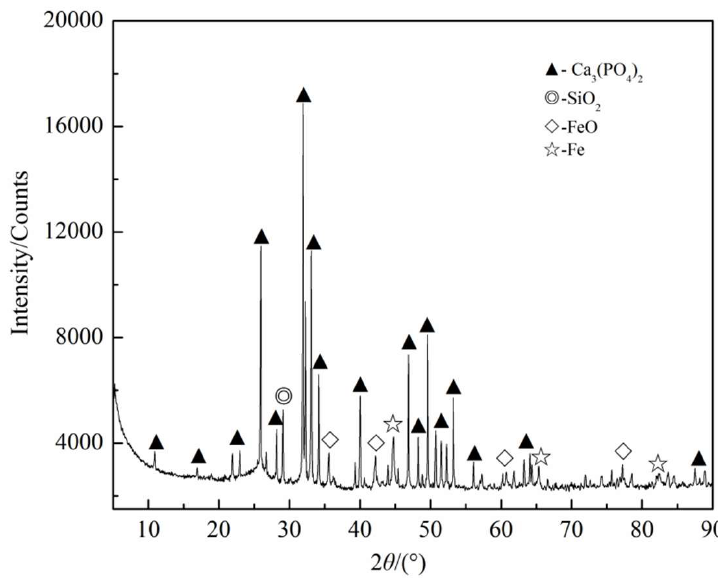
Figure 6. XRD analysis of the Ca 3 (PO 4 ) 2 –C–Fe 2 O 3 system after coal-based reduction.